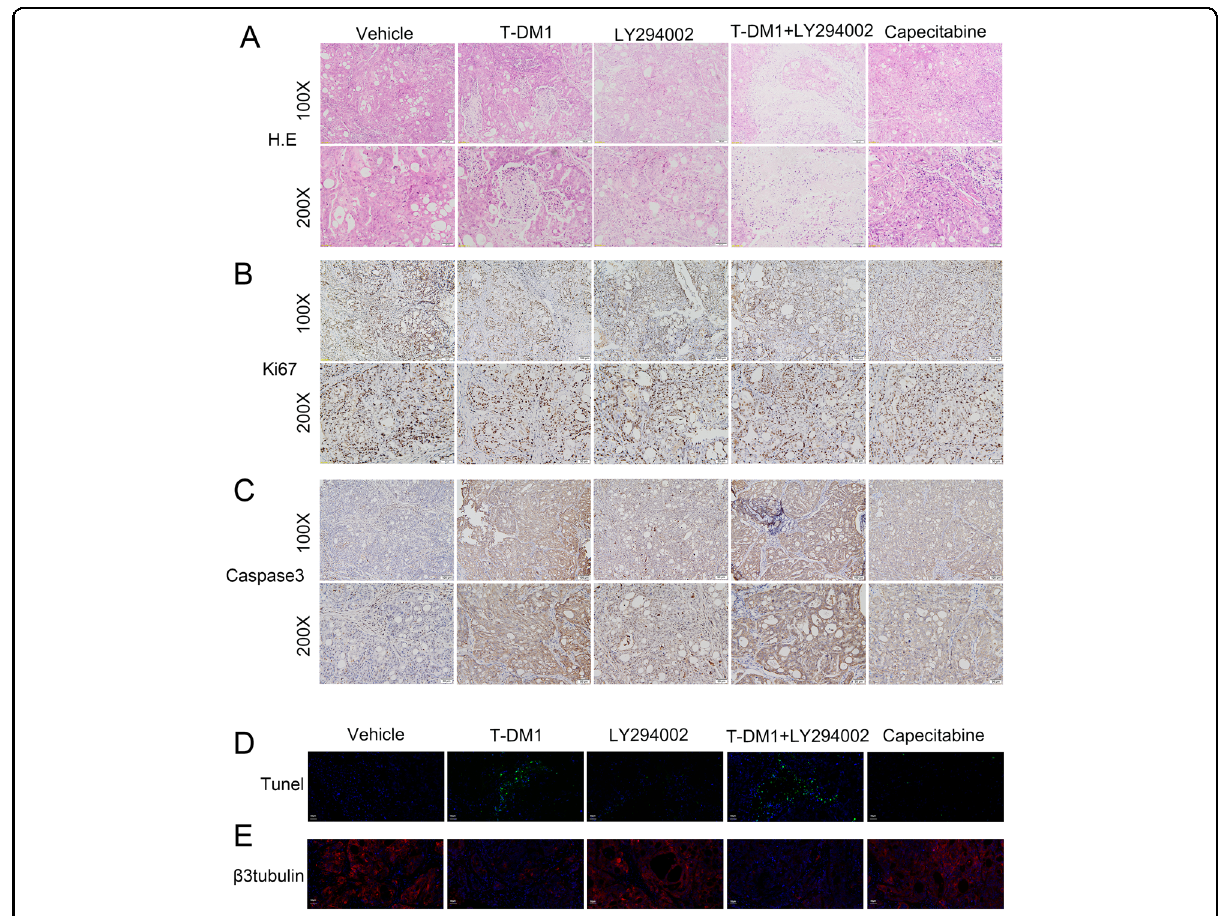
Fig. 6 Pathological results for NCI-N87 xenograft tumors. A Images of H&E staining of NCI-N87 xenograft tumors showed that treatment with T- DM1 and LY294002. B , C Images of immunohistochemical staining for Ki67 and caspase 3 in NCI-N87 xenograft tumors presented that treatment with T-DM1 and LY294002. D , E Images of immuno fl uorescence TUNEL and β 3-tubulin of xenograft tumors from mice treated with T-DM1 with or without LY294002 and the results of statistical analysis were presented in Supplementary Fig.